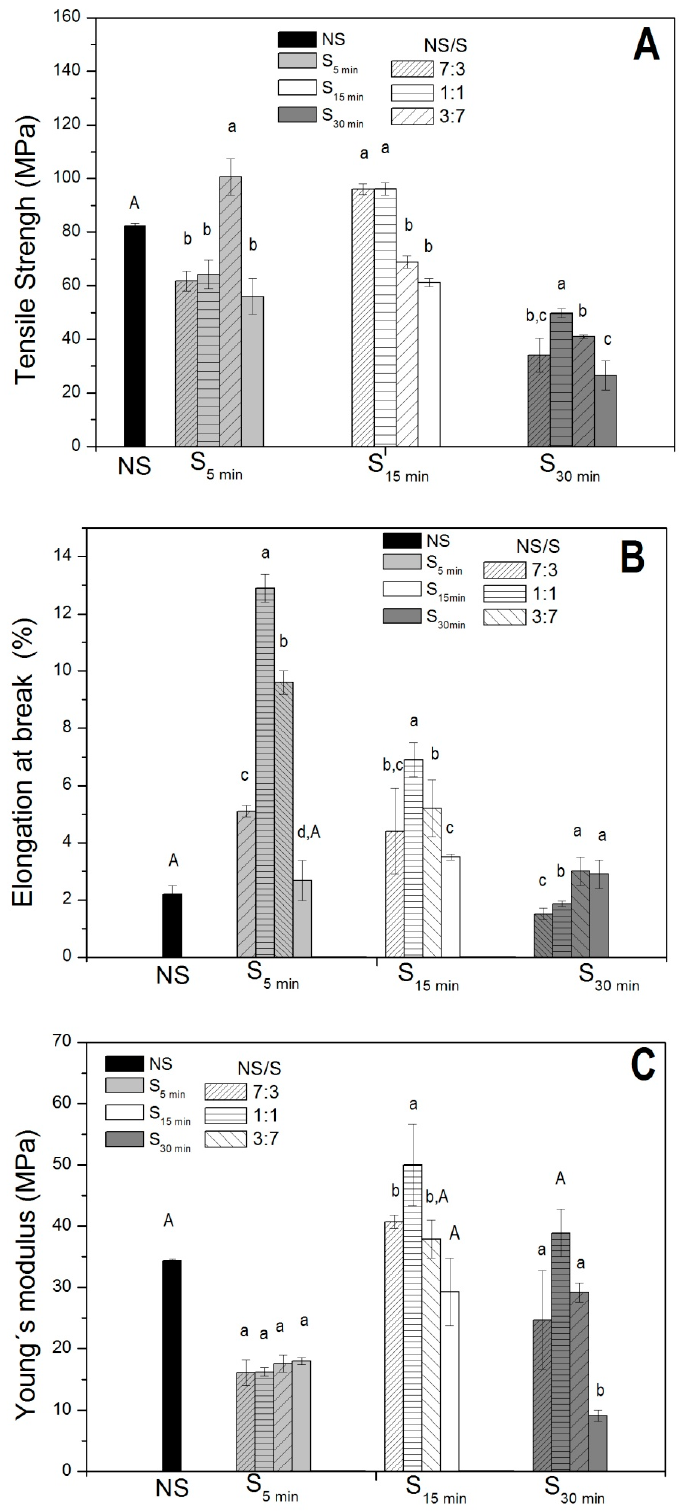
Figure 1. Mechanical properties of chitosan biobased films prepared from nonsonicated chitosan (NS) and nanosized chitosan sonicated at increasing times—5, 15, or 30 min (S 5min , S 15min and S 30min )—and NS/S blends. ( A ) Tensile strength, ( B ) elongation at break, and ( C ) Young’s modulus. NS/S 7:3, 1:1, and 3:7 ratios were evaluated for each film set. Same superscript letters within the same column indicate no differences at a significance level of p < 0.05 after the application of the Bonferroni test for each film set (S 5min , S 10min , and S 30min